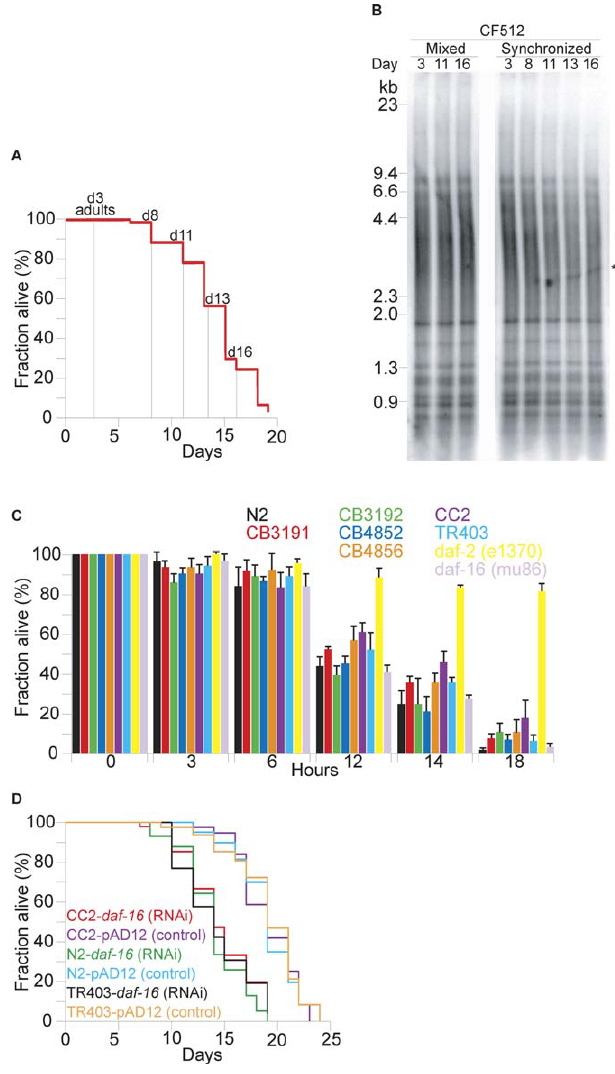
Figure 3. Telomere Length Is Independent from Organismal Life Span and Thermo Tolerance (A) CF512 temperature-sensitive sterile worms were grown at 25 8 C, and life span was monitored. Samples were taken at indicated times. (B) DNA from CF512 temperature-sensitive sterile worms was extracted at the indicated time points, and telomere length was monitored in mixed and synchronous populations (for details, see Materials and Methods). Telomere length is indicated in kb. The asterisk points out a variable band-like signal resulting from gel drying. (C) Seven different worm strains and daf-2 and daf-16 RNAi suppressed worms (indicated in different colors) with genetically determined telomere length (Figure 1D) were subjected to heat treatment as described [31]. Survival was assessed at the indicated time points. (D) Two worm strains with long telomeres (CC2, TR403) and N2 worms with short telomeres were subjected to daf-16 suppression by RNAi. Life spans were determined as described. DOI: